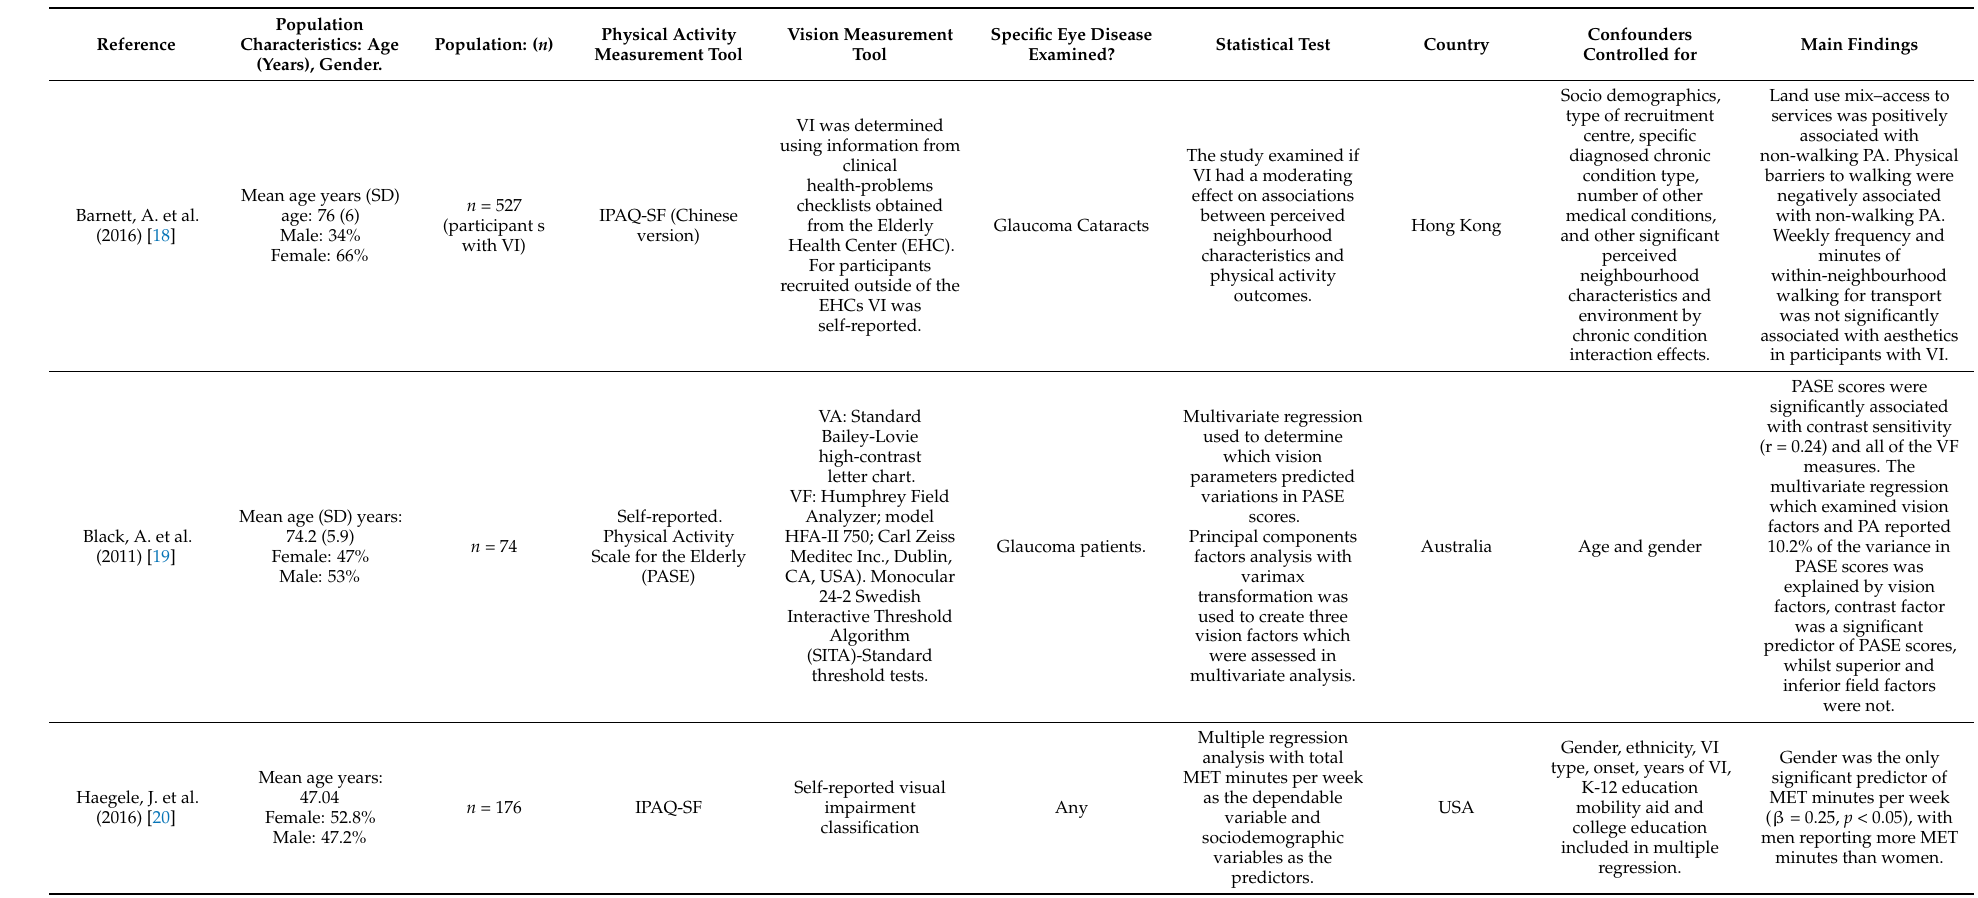
Table 1. Characteristics of eligible